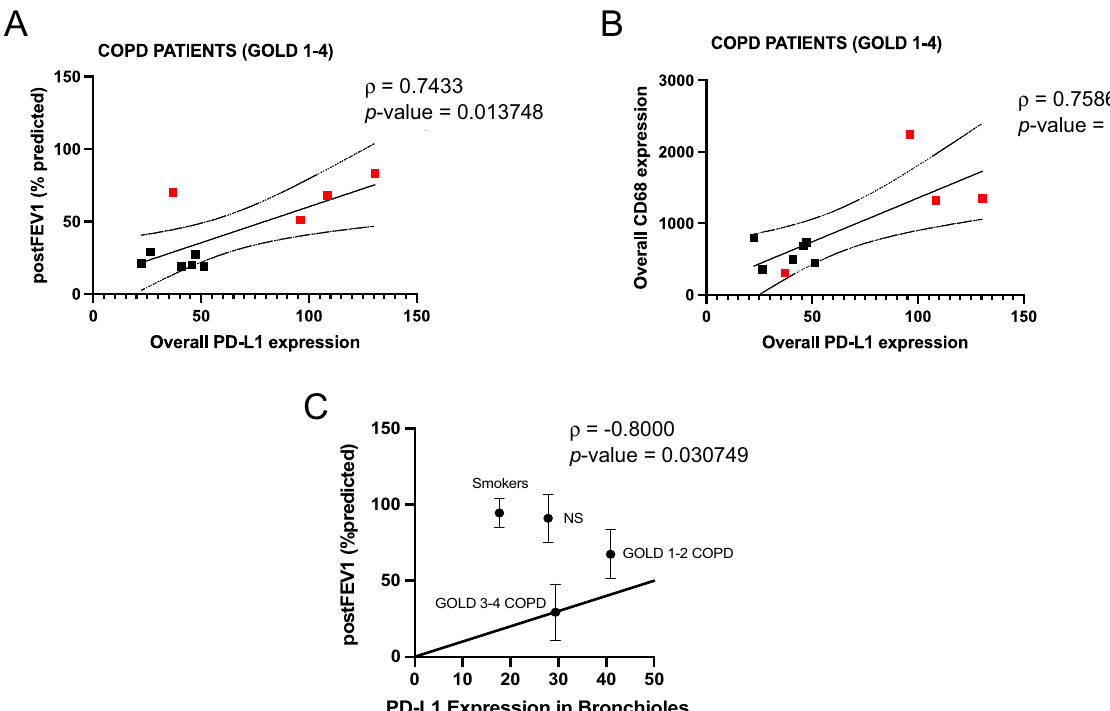
Figure 5. PD-L1 expression directly correlates with lung function and with CD68 expression: Correlation between total spatial PD-L1 expression levels and post-FEV1 (% predicted) ( A ) and spatial PD-L1 and CD68 expression levels ( B ) across all the COPD patients. Results were shown as means ± SEM. Red squares indicate GOLD 1–2 COPD patients. ( C ) the correlation between spatial PD-L1 expression and post-FEV1 (%